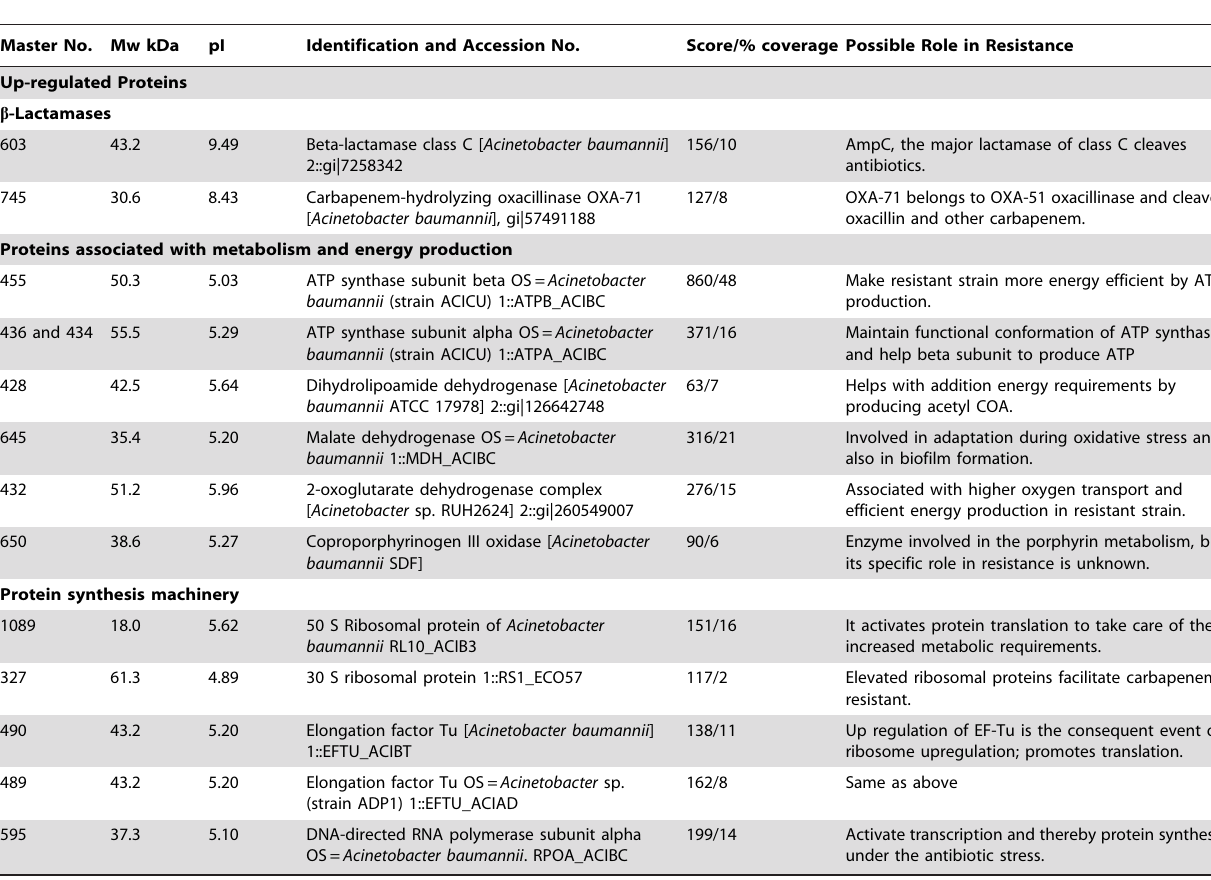
Differential expression is shown as fold change (minimum 2 fold, p-value e0.05).